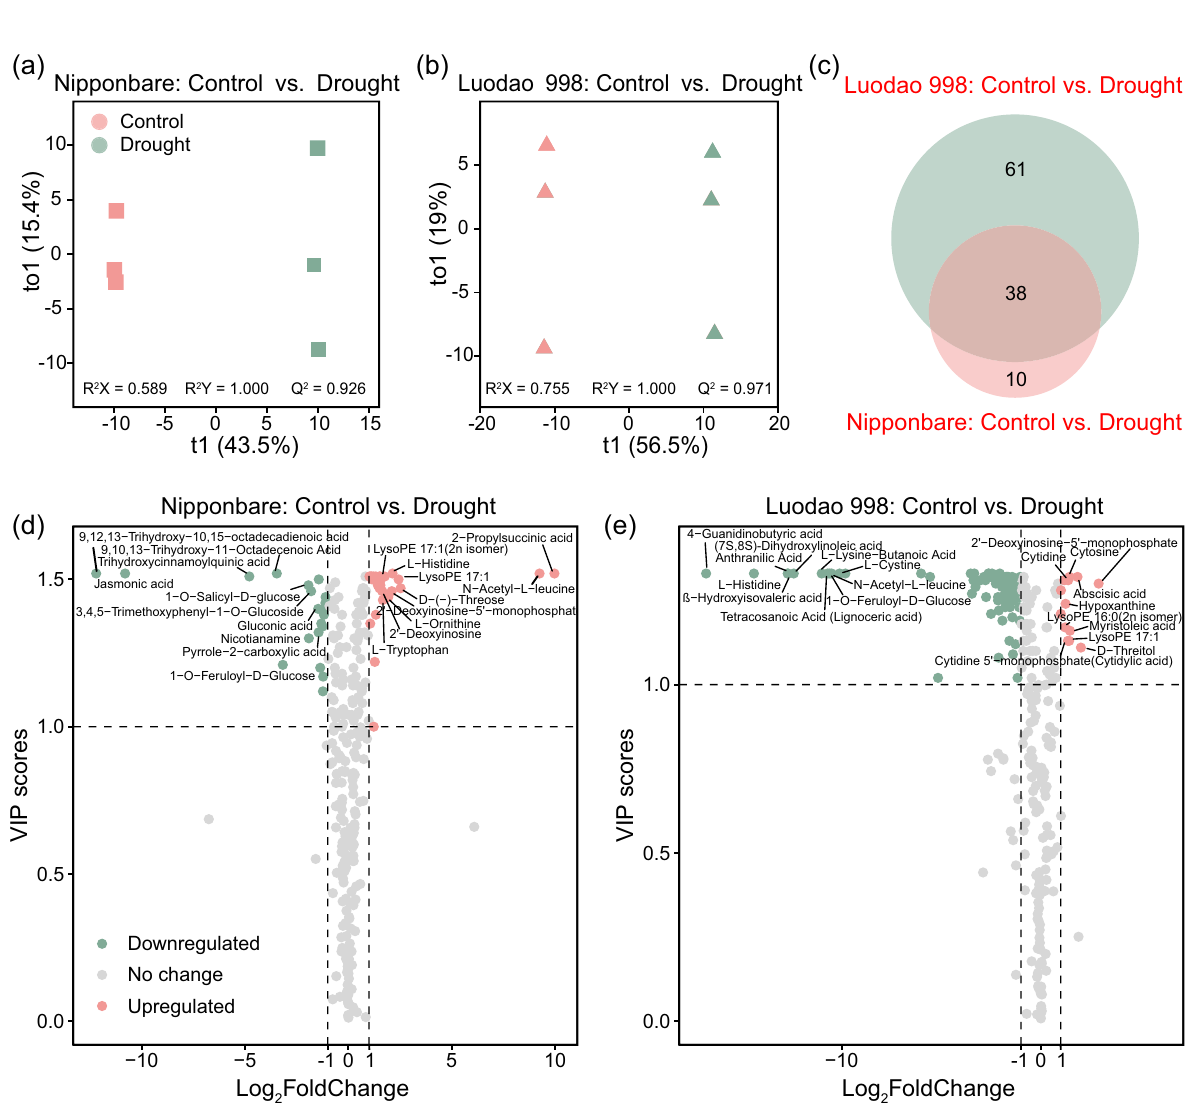
Fig. 5 Changes in root exudate composition between different watering treatments. ( a , b ) Metabolomic profiles of root exudates between control and drought conditions in the two rice genotypes assessed by OPLS-DA. c Number of differential metabolites between different watering groups in the two rice genotypes. Volcano plots of differential metabolites between control and drought treatments in d Nipponbare and e Luodao 998. The top 10 differential metabolites with the largest and smallest fold changes are labelled with